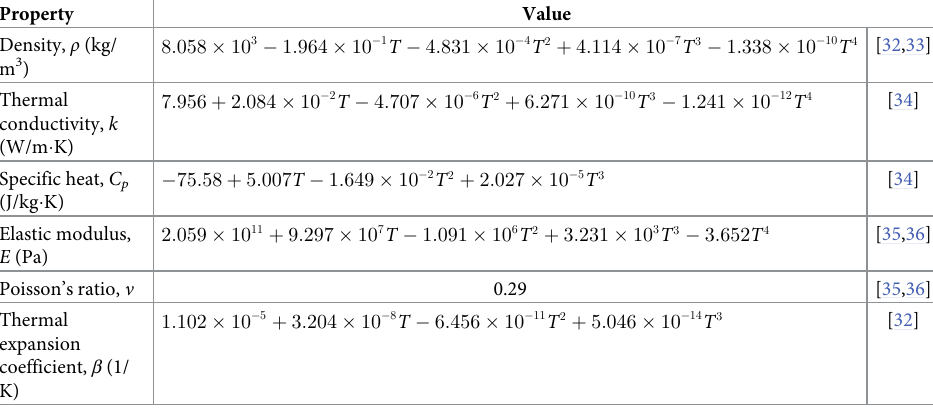
Table 3. Material properties of stainless-steel Type 316 used for modelling the isochoric chamber